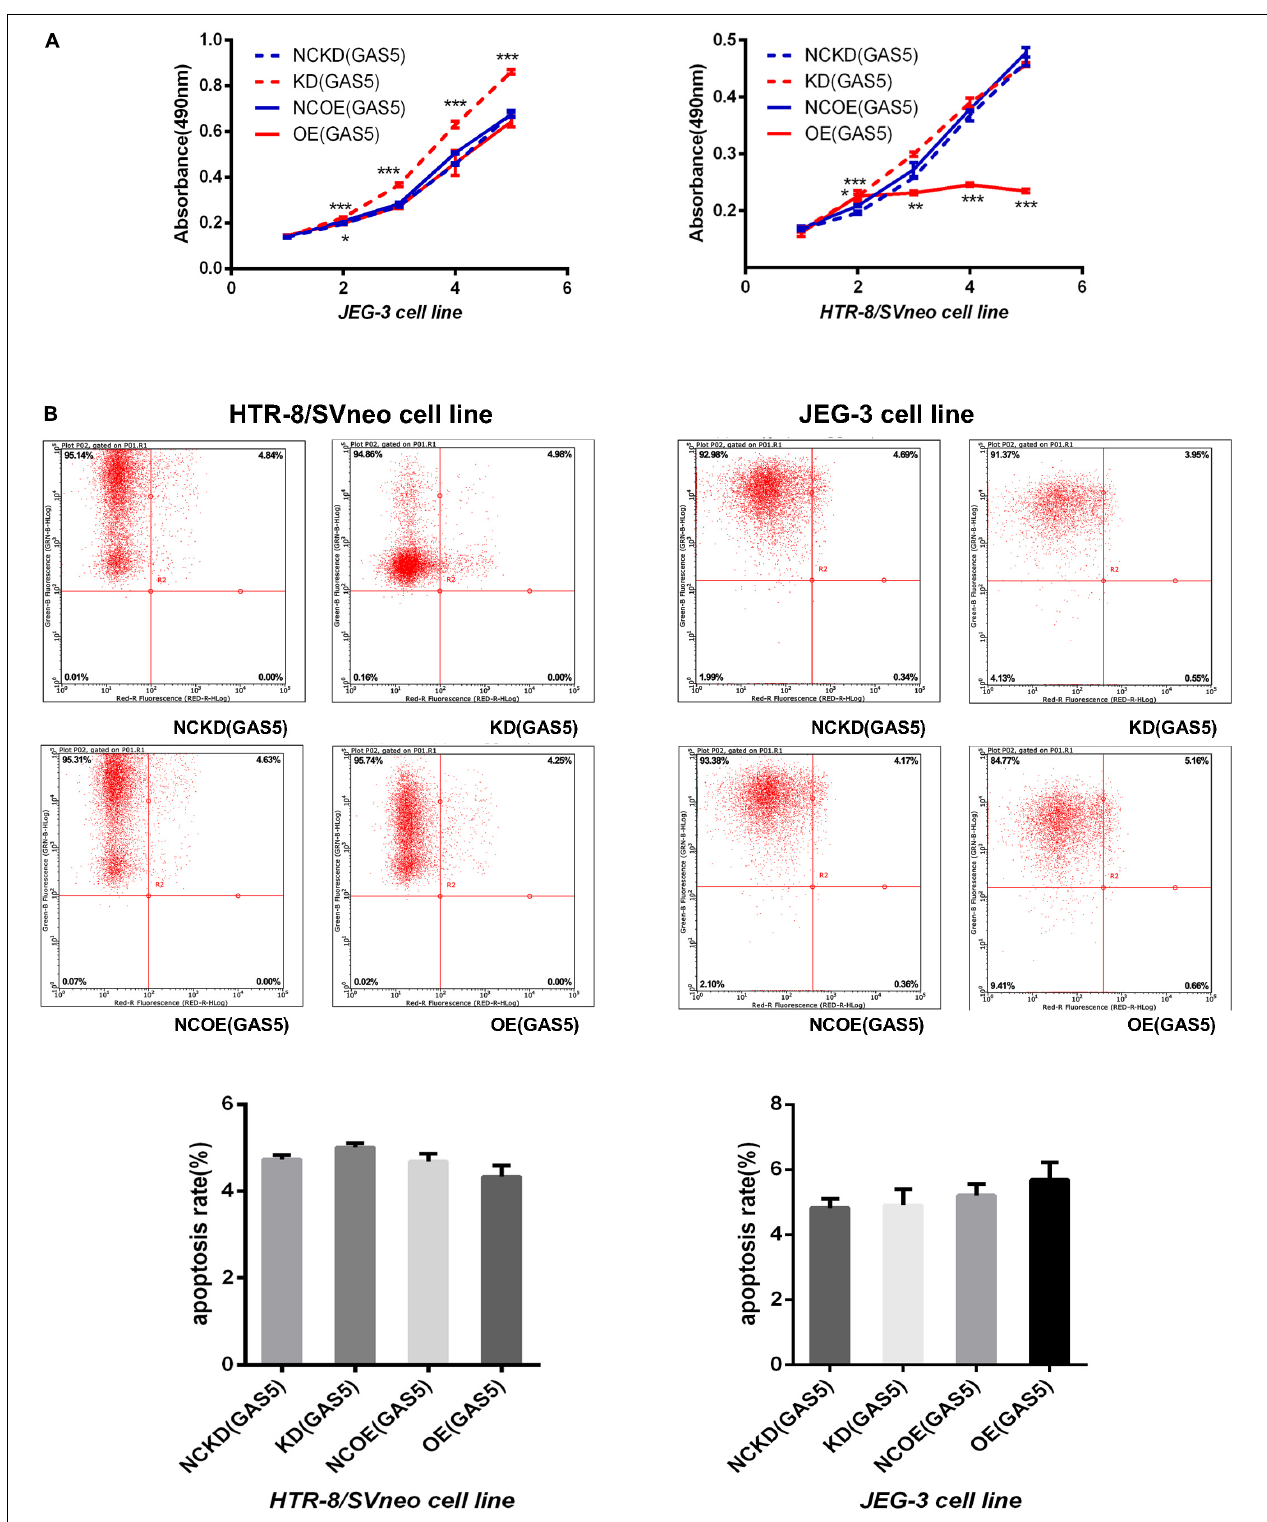
FIGURE 3 | (A) The MTT assay indicated that knockdown of GAS5 promoted the proliferation of trophoblast while overexpression of GAS5 inhibited the proliferative ability on the contrary. (B) With no significant incidence of apoptosis, GAS5 didn’t influence the apoptosis rate in both of the two cell lines. * P < 0.05, ** P < 0.01, *** P <